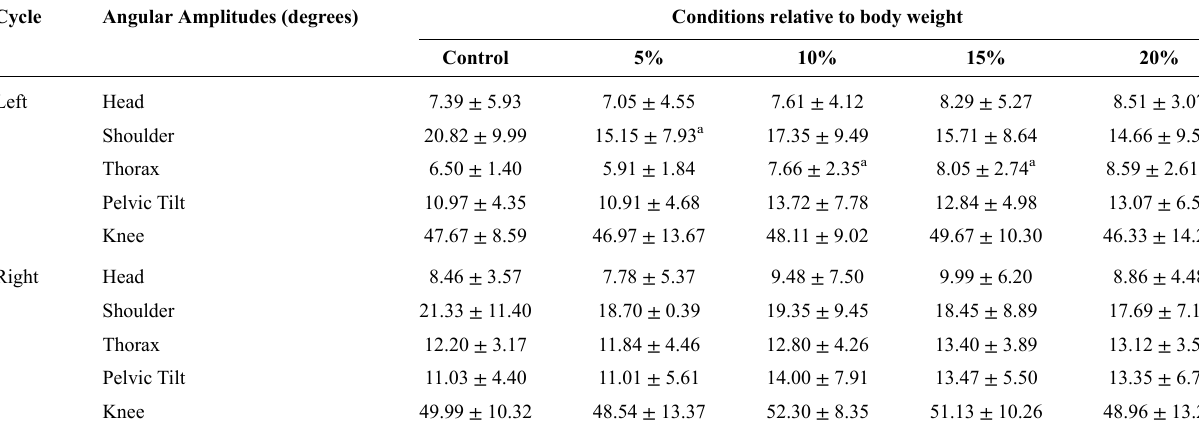
Table 2 - Comparison of the angular amplitudes considering the conditions relative to body weight.